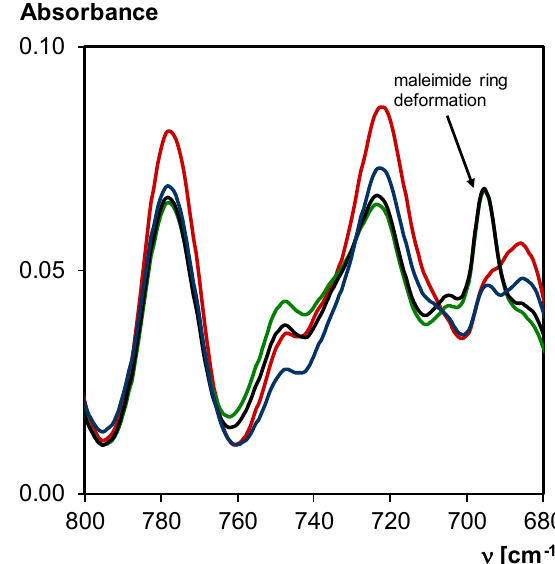
Figure 9. Transmission FTIR spectra of 3M-F375PMA in a KBr pellet at 20 ◦ C, normalized to the C–O–C symmetric stretching vibration at 1200–1050 cm − 1 (not shown). Red : material at starting conditions; Green : 1st time retro Diels–Alder reaction (after 15 min at 100 ◦ C); Black : 4th time retro Diels–Alder reaction (after 15 min at 100 ◦ C); Blue : material at starting conditions after thermal cycling (fourth cycle after seven days at 20 ◦ C).